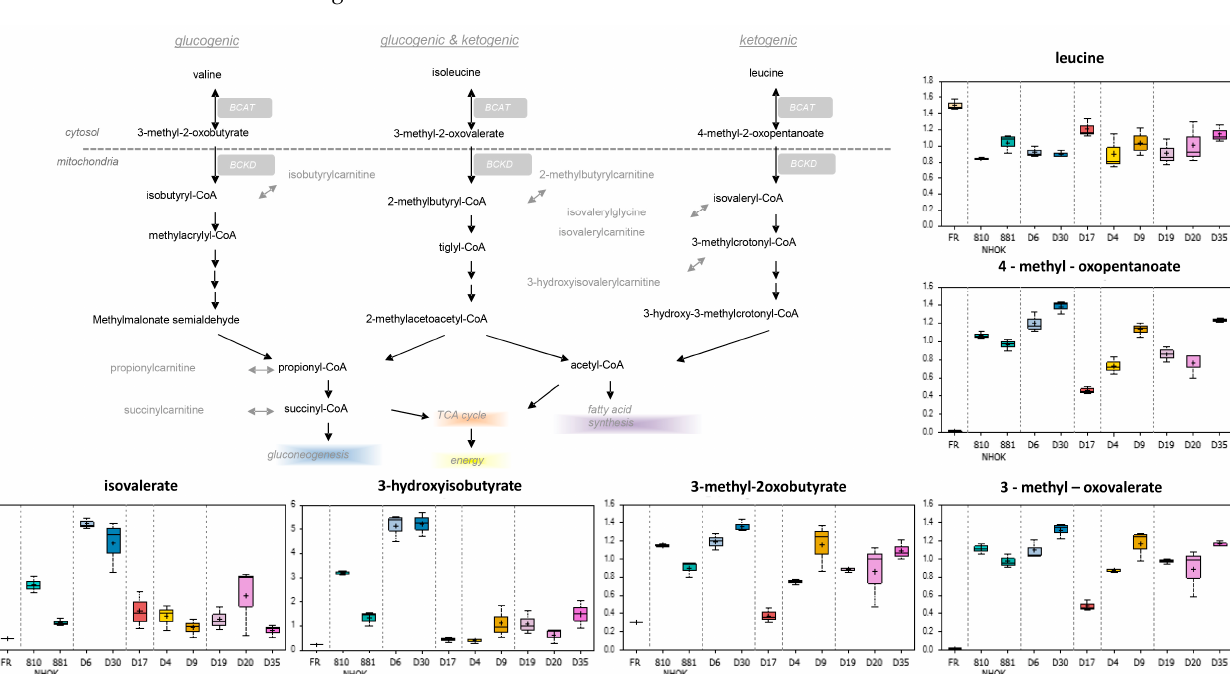
Figure 2. Characterisation of the senescence markers in the cell lines used in this study. Western blots of ( A ) p16 INK4A in normal keratinocyte NHOK810 (N—blue colour bar above Western blot images and in graph), normal oral keratinocytes immortalised by telomerase (NI—beige colour) retaining (OKF4) or lacking (OKF6) p16 INK4A expression, low-risk mortal potentially premalignant oral lesion D6, D25, D30, and E4 (LR MPPOL—green colour), LR MPPOL extended lifespan D17 (p16 INK4A − / − —orange colour), and a representative of high-risk immortal potentially premalignant oral lesion D19 (HR